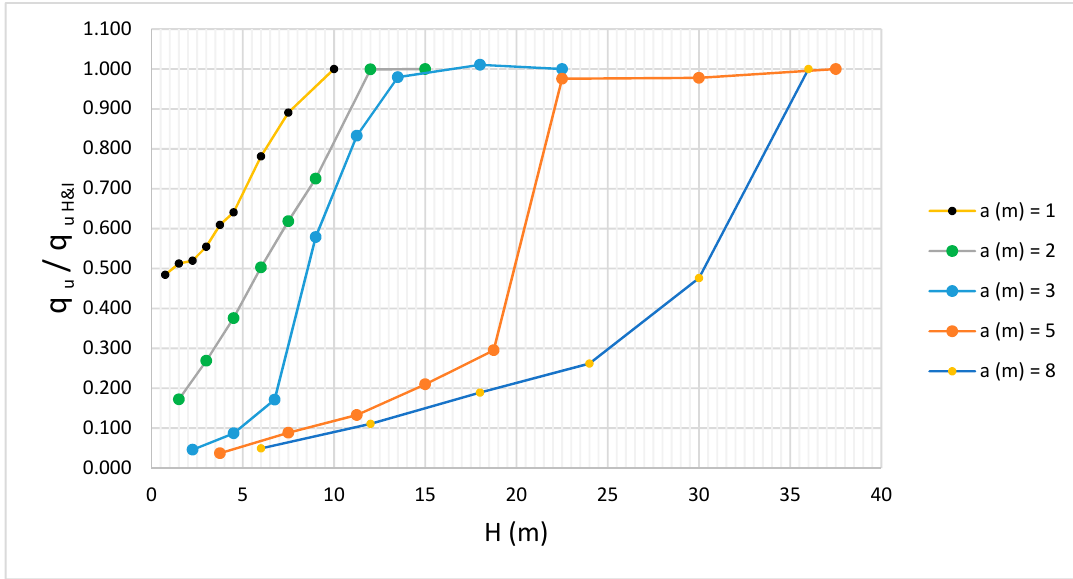
Figure 14. Influence of cavern depth (H) on the ultimate bearing capacity when varying the load eccentricity.